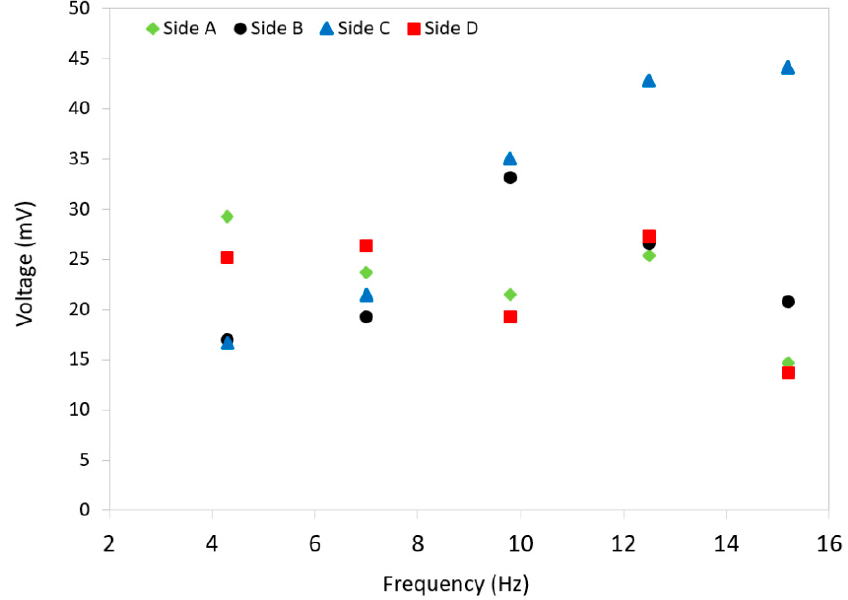
Figure 7. A comparison between the peak voltage amplitudes of all four sides of the harvester at different frequencies.